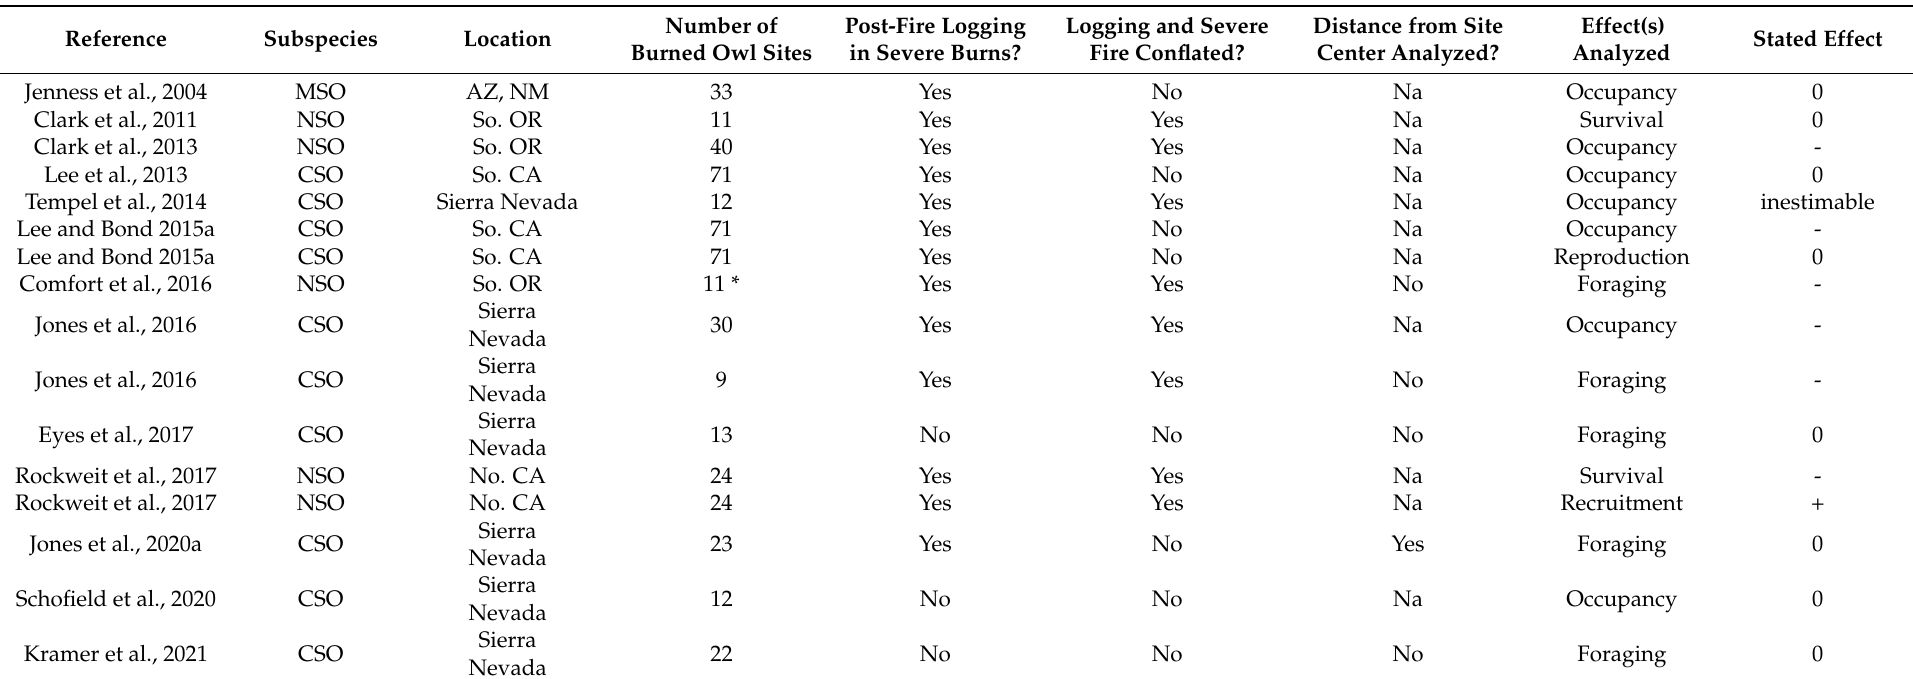
Table 1. Summary results of 13 Spotted Owl studies reporting one or more negative effects of high-severity fire (this included studies reporting mixed negative/positive effects). Data include article reference; subspecies of Spotted Owls (MSO = Mexican Spotted Owl, NSO = northern Spotted Owl, CSO = California Spotted Owl); geographic location (AZ = Arizona, NM = New Mexico, So. OR = Southern Oregon, So. CA = Southern California, No. CA = Northern California); number of burned Spotted Owl breeding sites in the study; whether post-fire logging occurred; whether post-fire logging and high-severity fire were conflated in the study; whether distance from site center was analyzed in foraging selection studies; effects analyzed; statistically significant result as stated in the article (0 = no effect, + = positive effect, - = negative